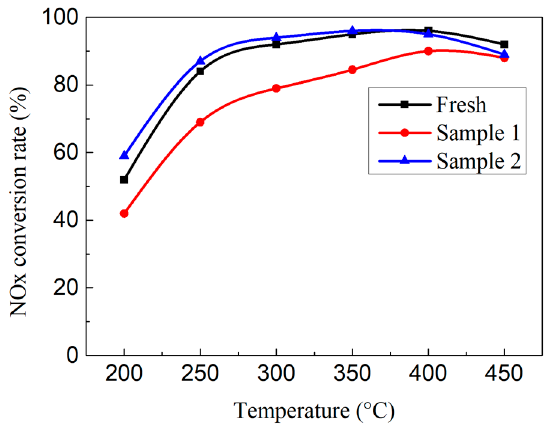
Figure 16. Evaluation of sample 1 and 2 at different temperatures.